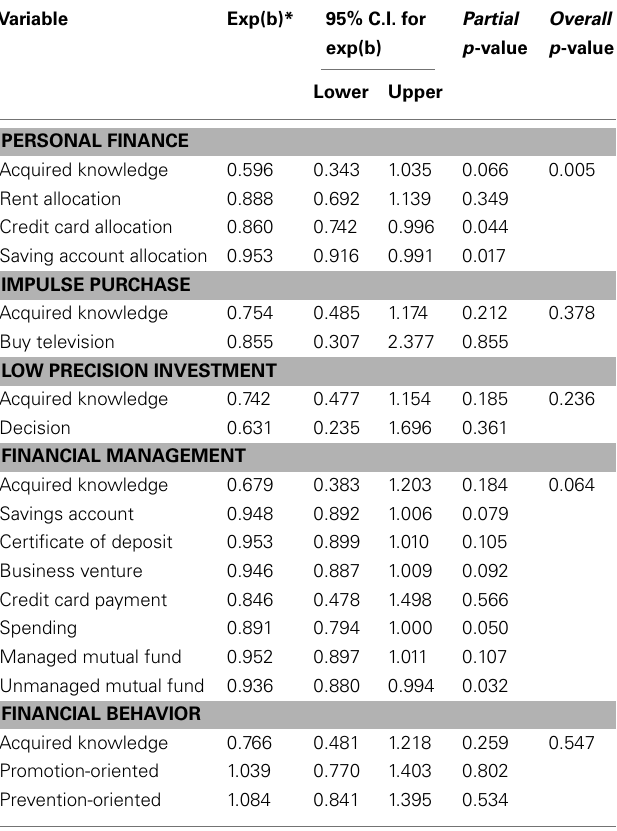
Table 2 | Logistic Regression Models of FDMQ Scenarios to Sex (i.e., Male vs.